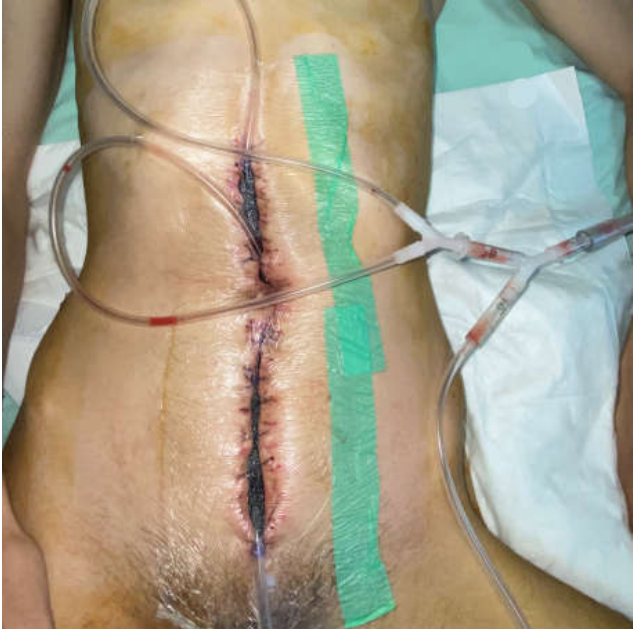
Figure 3. The technique with a suction drain in the fistula (in the middle) and separation of the EAF from the upper and lower part of the wound using two sponges and separate suction.